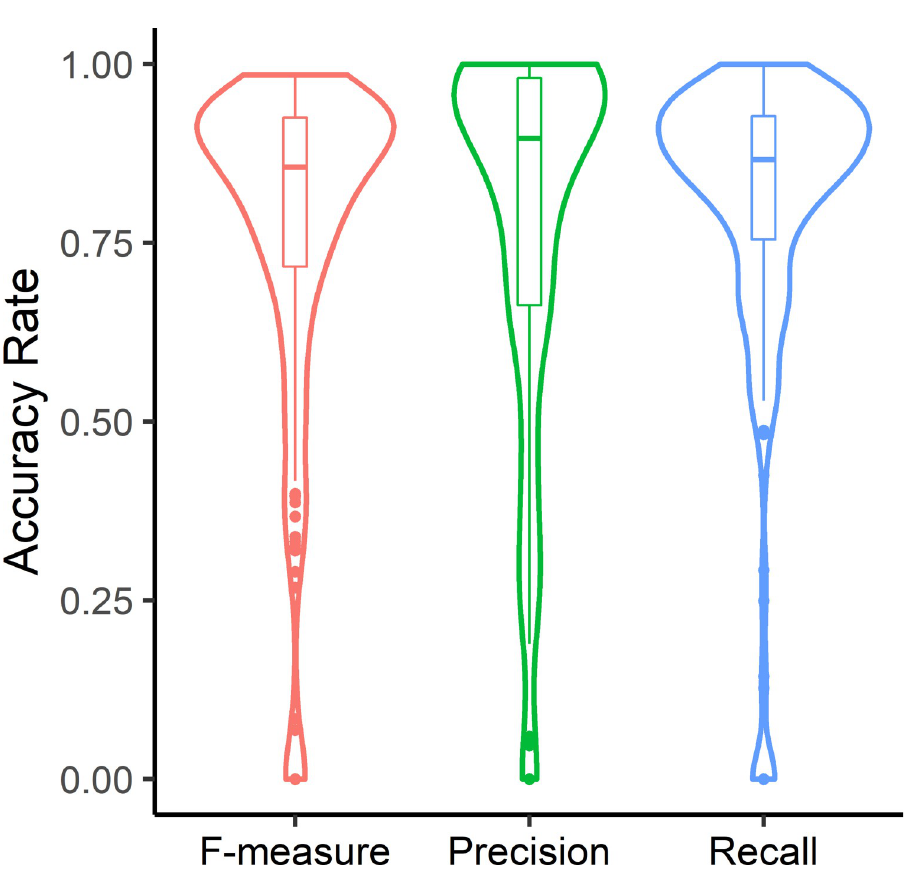
Fig 6. Violin plots and boxplots showing the distribution of the F-measure, Precision, and Recall values calculated by POSEA for each segmented object within the activated T cell images (n = 225 cells from 5 images).